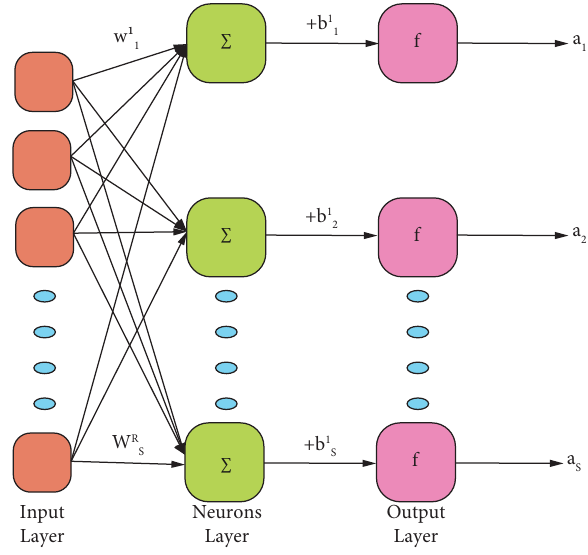
Figure 1: Single layer network with R/S